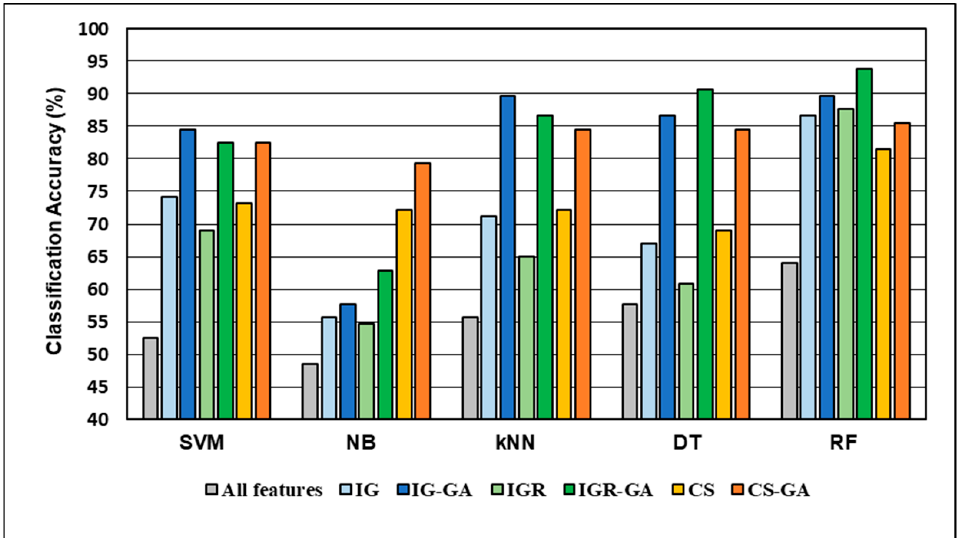
Figure 3. The accuracy comparison of classifiers using all features, the features selected only by filters methods, and the features selected by the proposed hybrid filter-GA methods on the Breast Cancer dataset.